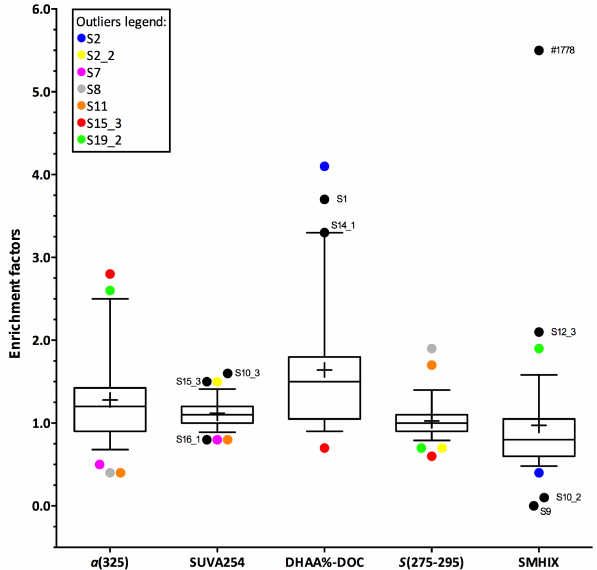
Figure 4. Box and Whiskers plot of enrichment factors for CDOM absorption coefficient a (325), aromaticity (SUVA 254 ) , DOM diage- netic state (DHAA%-DOC), spectral slope S (275–295), and modi- fied surface microlayer humification index (SMHIX). The horizon- tal lines of the boxes represent 25%, 50% (median) and 75% per- centiles (from bottom to top). In the boxes, crosses represent the mean. Whiskers represent minimum and maximum values, and cir- cles are outliers. Outliers are staggered to better visualize them. To identify the station, see outliers’ labels and color legend. For a (325), SUVA 254 and S (275–295) n = 38. For SMHIX, n = 37 and for DHAA%-DOC n =